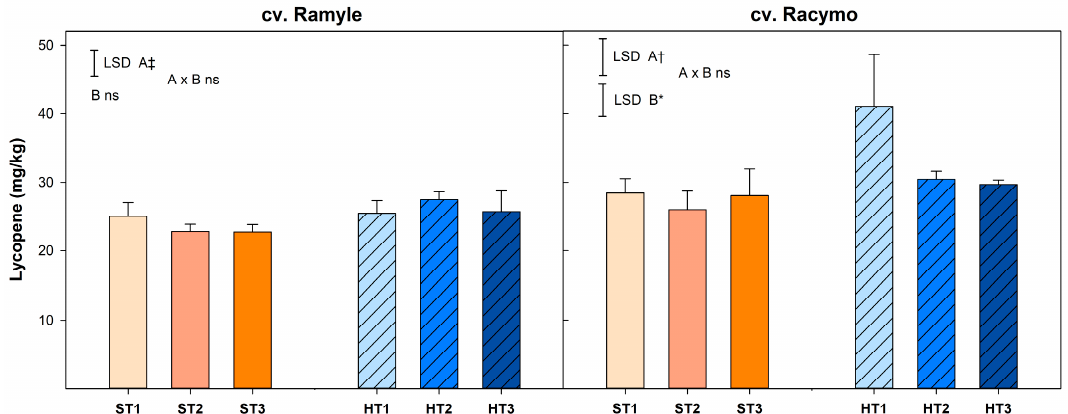
Figure 5. Lycopene content of two tomatoes (cvs. Ramyle and cv. Racymo) under different irrigation treatments (T1: desalinated seawater with low electrical conductivity (EC); T2: well/desalinated water, intermediate EC; and T3: well water with high EC) and cultivation systems (traditional soil system, S; hydroponic, H) ( n = 3 ± SD). The uppercase letters A and B denote cultivation system and irrigation treatment, respectively. ns, *, † , and ‡ significance for p ≤ not significant, 0.05, 0.01, and 0.001, respectively.